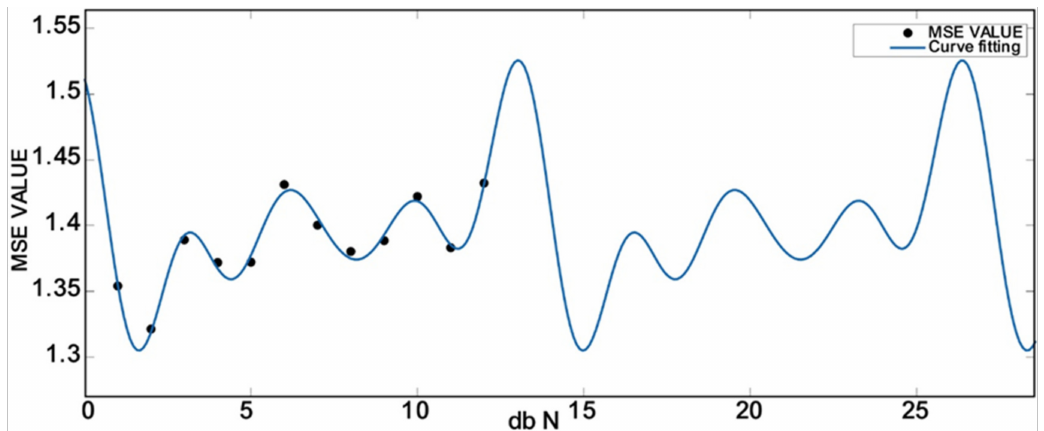
Figure 7. The MSE fitting curve of the db wavelet packet